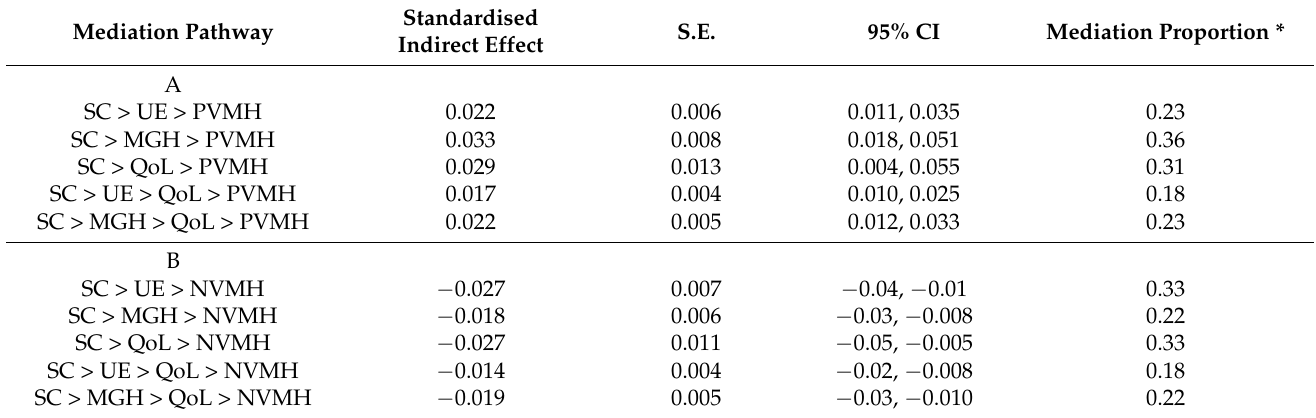
Table 2. Indirect effects for the indirect pathways explaining the relationship between self-care and positive vitality/mental health ( A ) and negative vitality/mental health ( B ). Bias-corrected bootstrapping was used. SC, SCIM—Self-Care; UE, self-efficacy for unexpected events; MGH, self-efficacy for maintaining good health; QoL, self-appraisal for quality of life; PVMH, positive vitality/mental health; NVMH, negative vitality/mental health.